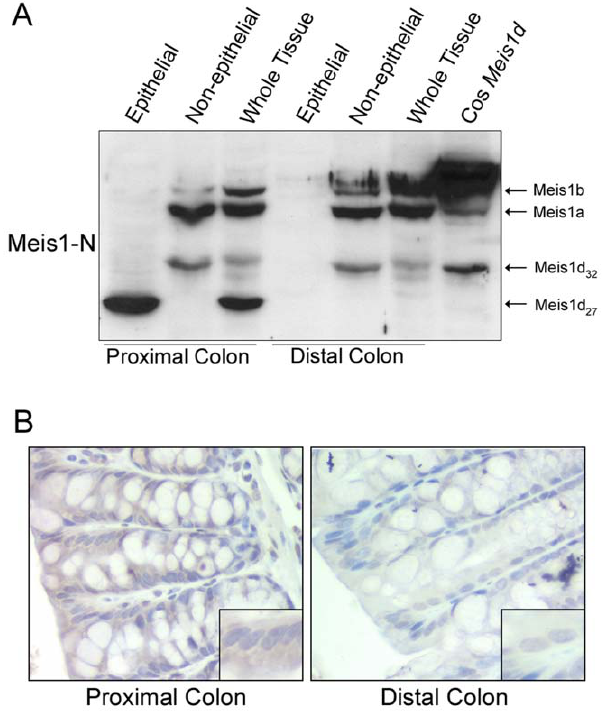
Figure 4. Meis1d 27 and Meis1d 32 are expressed in different cellular populations. A) B6 proximal and distal colon samples were separated into epithelial and non-epithelial fractions. The non-epithelial fractions consist of the lamina propria and muscle layers of the colon. The fractions and whole cell lysates from both colon segments were probed with the Meis1-N antibody. Cos-1 cells expressing Meis1d were used to compare the in vitro and in vivo molecular weights of Meis1d 32 . B) B6 proximal and distal colon samples were stained with Meis1-N antibody. Staining was visualized at 20 6 magnification.